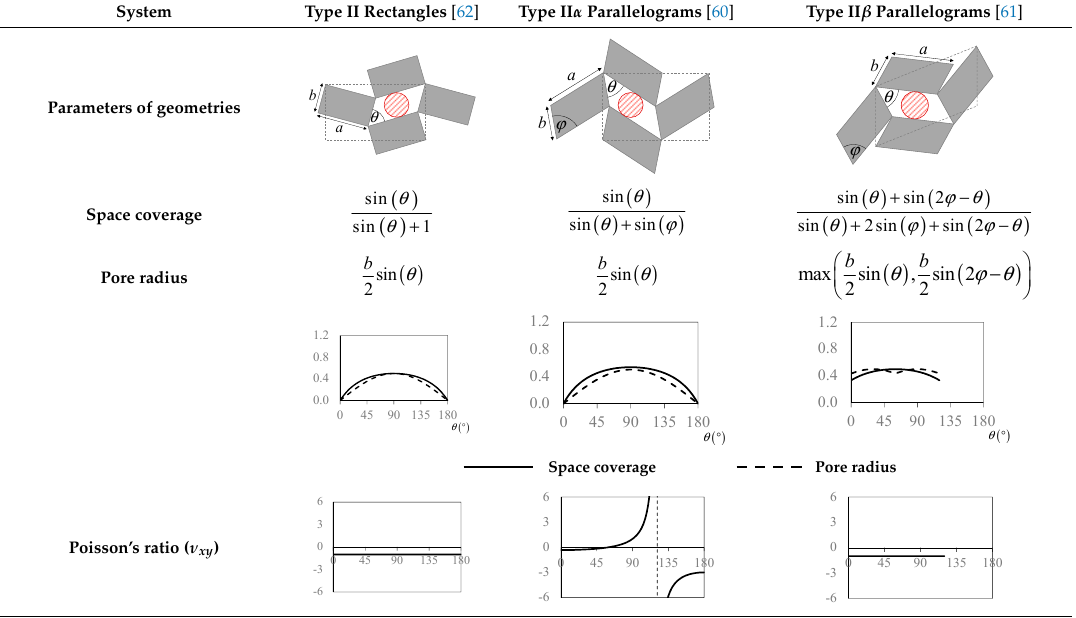
Table 2. Expressions relating space coverage, pore radius (radius of circle inscribed in the pore) and Poisson’s ratios to geometric parameters of the systems for cases where a > b . The vertical dashed line Table 2. Cont. in the plots of the Poisson ratios represents asymptotic behavior that occurs when the system is locked in the loading direction.